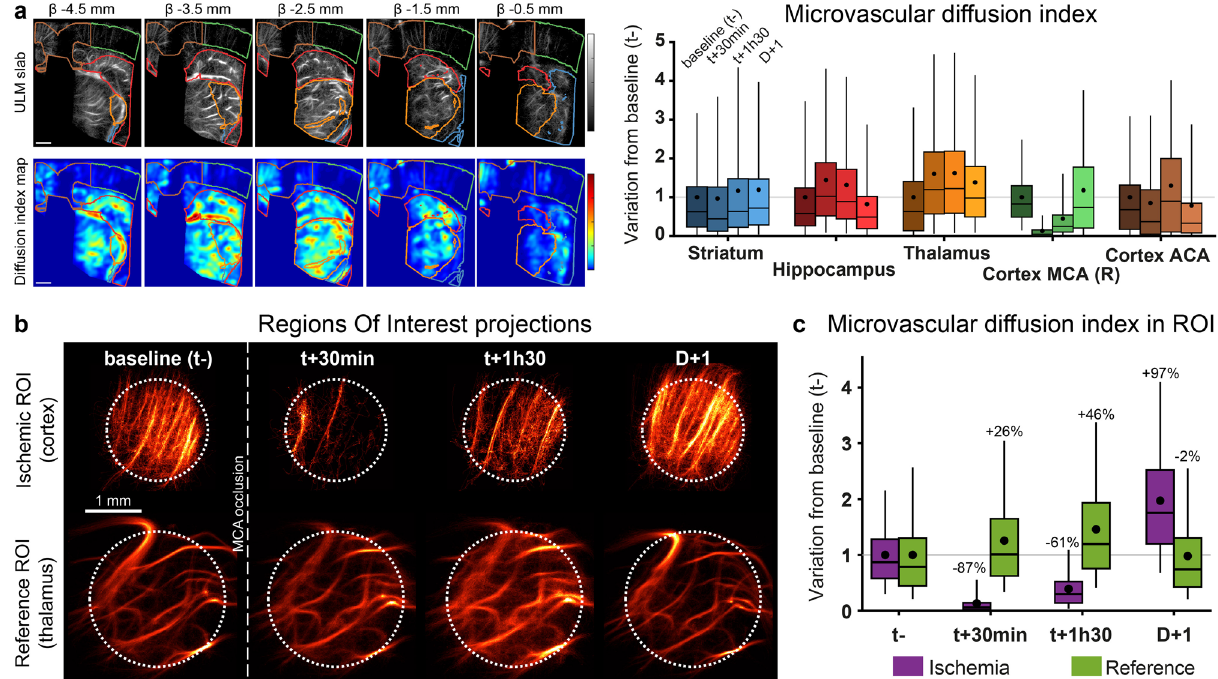
Figure 4. Sudden and massive loss of perfusion in the cortex. (a) Coronal slices of MDI with anatomical regions. MDI values inside each region normalized with t−. Scale bar 1 mm, slices of 600 µm. (n = 1). ( b) Projection of the selected ROI in the cortex and thalamus as a reference. c MDI values for the ROI inside ischemia and the reference, normalized with baseline (t−). (Results of the analysis of 1 animal over 4.) Box plot: mean (dot), median (line), 1 and 3 quartile (box), 5 and 95% (whiskers). Figures were created with (a–c). MatLab 2019a (https:// www. mathw orks. com/ produ cts/